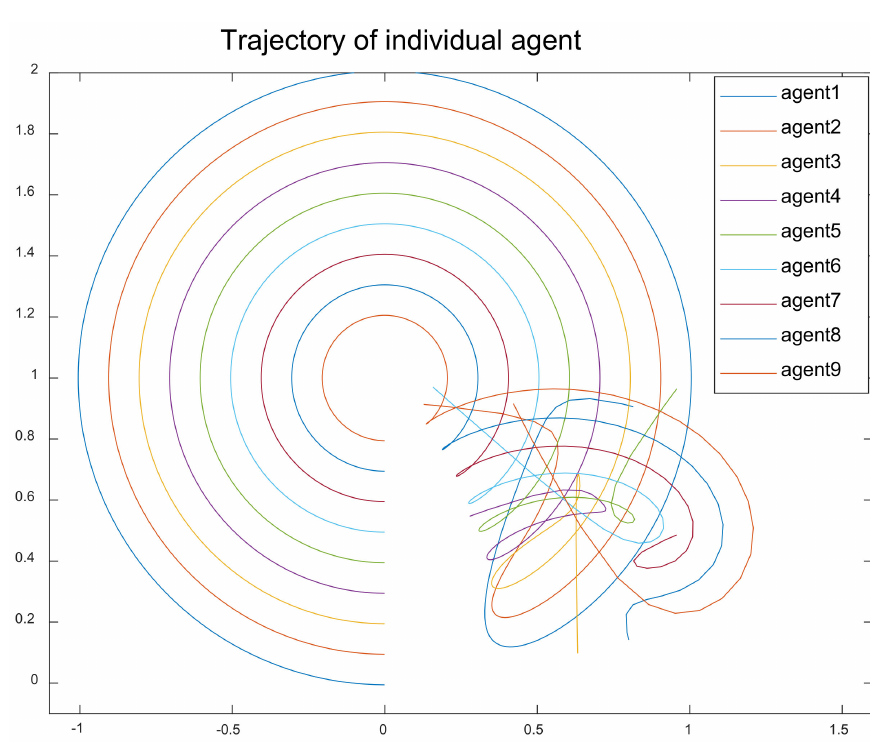
Figure 13. Trajectory of individual